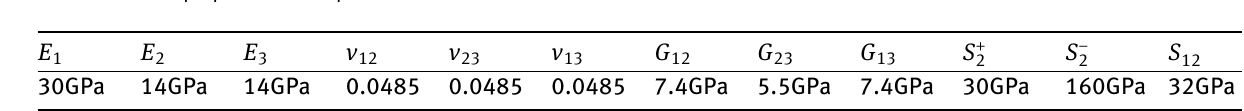
Figure 3: The external normal stress application device design Table 1: Material properties of composite